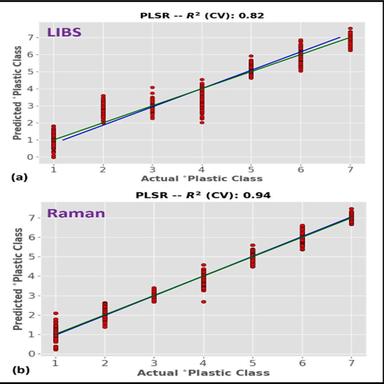
PLS cross-validation of spectral data collected from plastic samples (a) LIBS and (b) Raman data (labels: 1-PET, 2-HDPE, 3-PVC, 4-LDPE, 5-PP, 6-PS, and 7-PMMA).